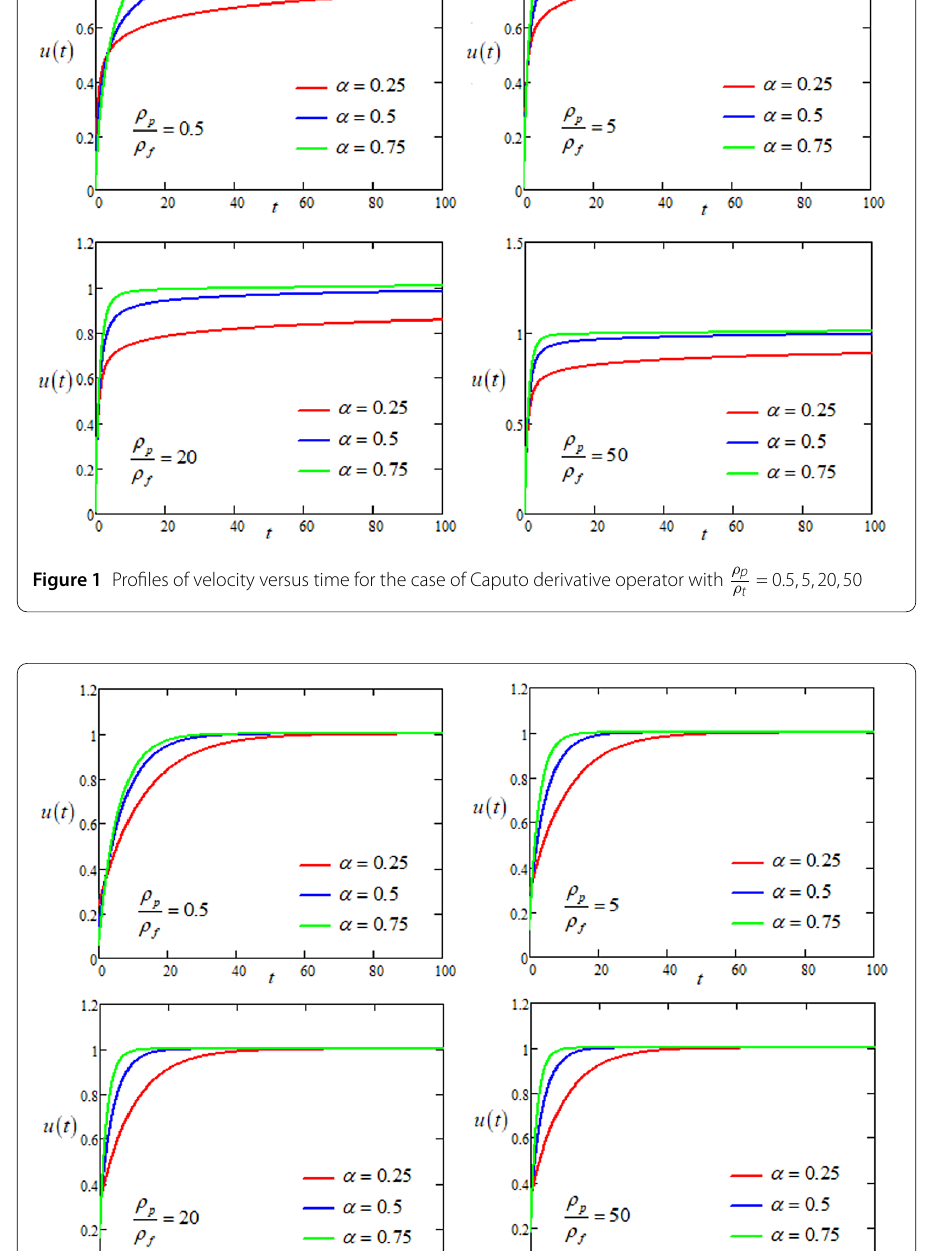
Figure 2 Profiles of velocity versus time for the case of Caputo–Fabrizio derivative operator with ρ p ρ t = 0.5,5,20,50